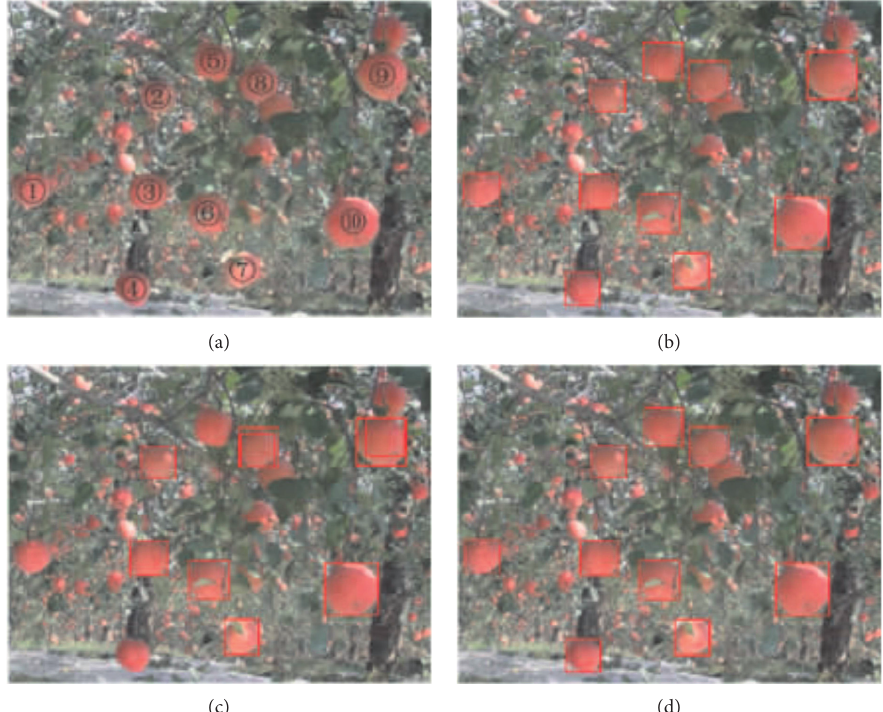
Figure 6: Comparison of the matching results. (a) Original image; (b) gray; (c) R-G; (d)